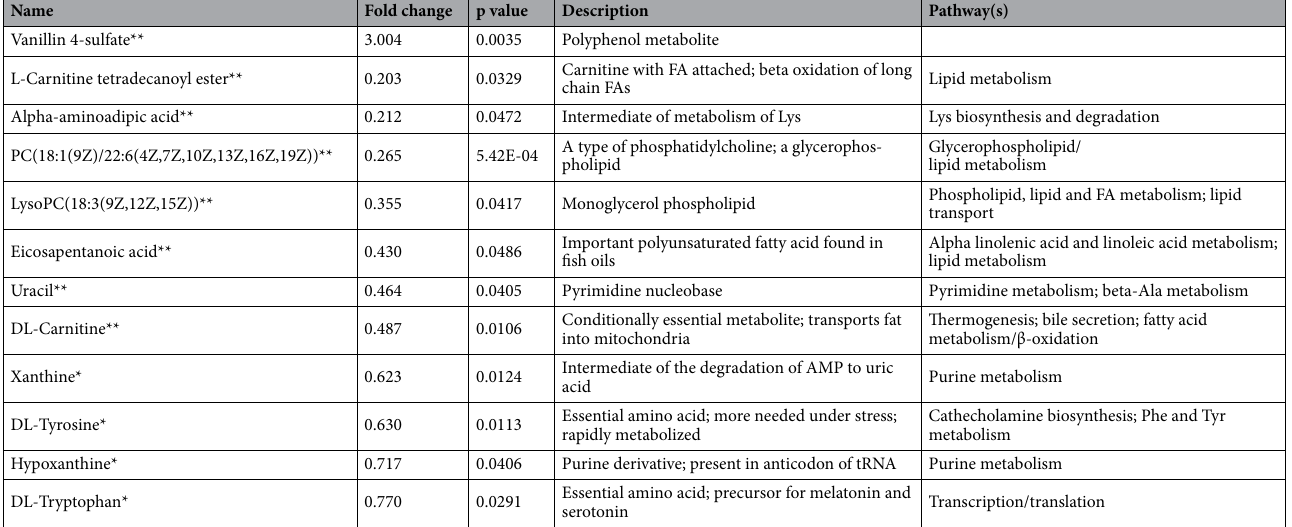
Table 2. Significant results from the untargeted metabolomic screen of liver from male Dex exposed offspring compared to their saline controls. Compounds identified as ** indicate metabolites that reached the two cut-off criteria (p < 0.05 and fold change > 2 or < 0.5) while compounds identified as * indicate metabolites that reach the p < 0.05 criteria only. Upregulations are presented first in descending order while downregulations follow (n =